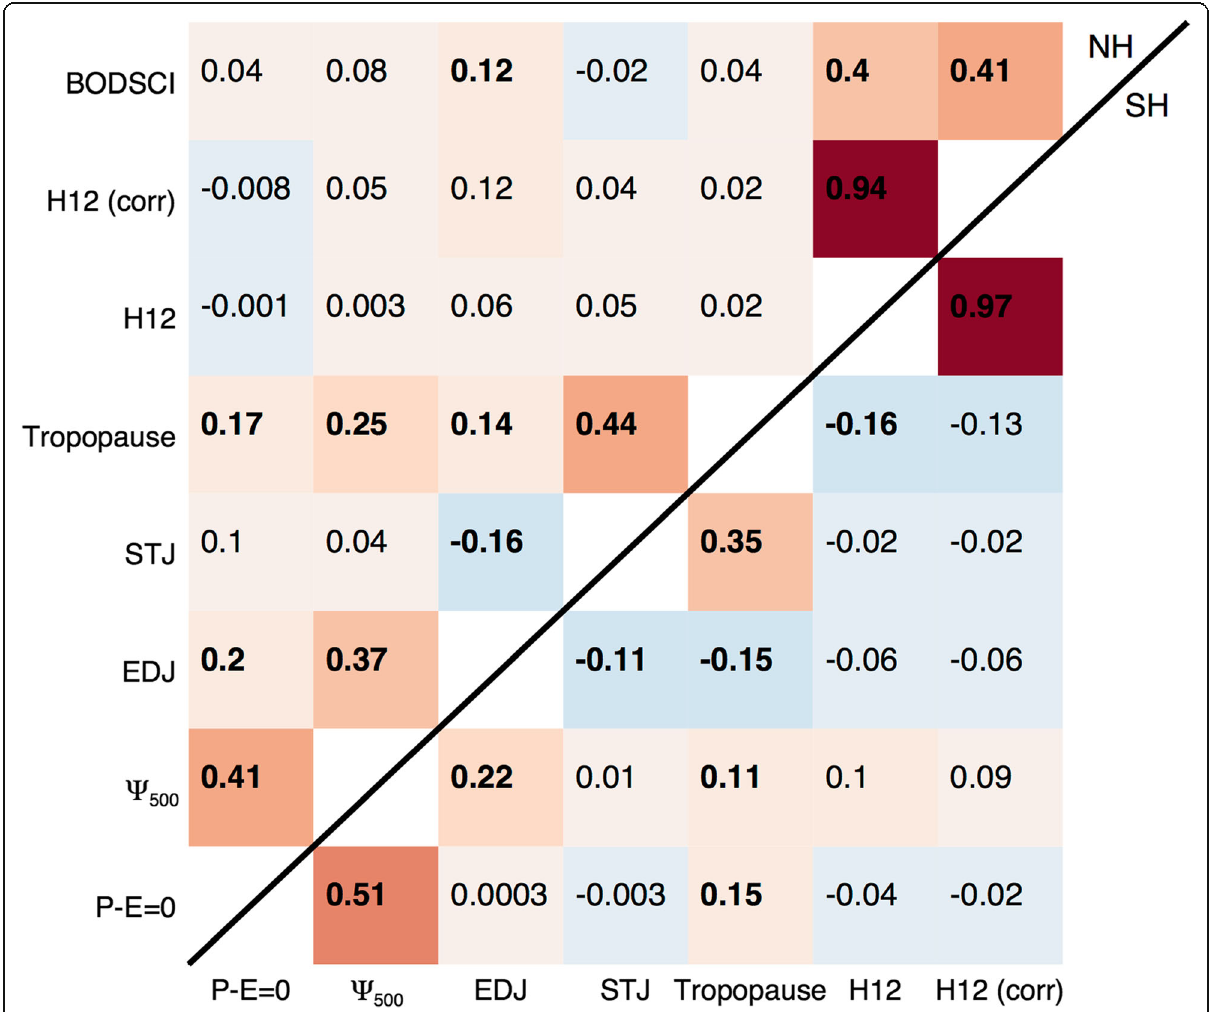
Fig. 5 Correlation coefficients between pairs of detrended monthly mean tropical width metric anomalies (1979 – 2010) from ERA-Interim reanalysis, calculations from Hudson 2012 (both raw and corrected versions), and our implementation of the Hudson 2012 method using BODSCI TCO data, color-coded by the value. The upper left is NH and the lower right is SH. Statistically significant correlations, taking into account autocorrelation of the timeseries, are shown in